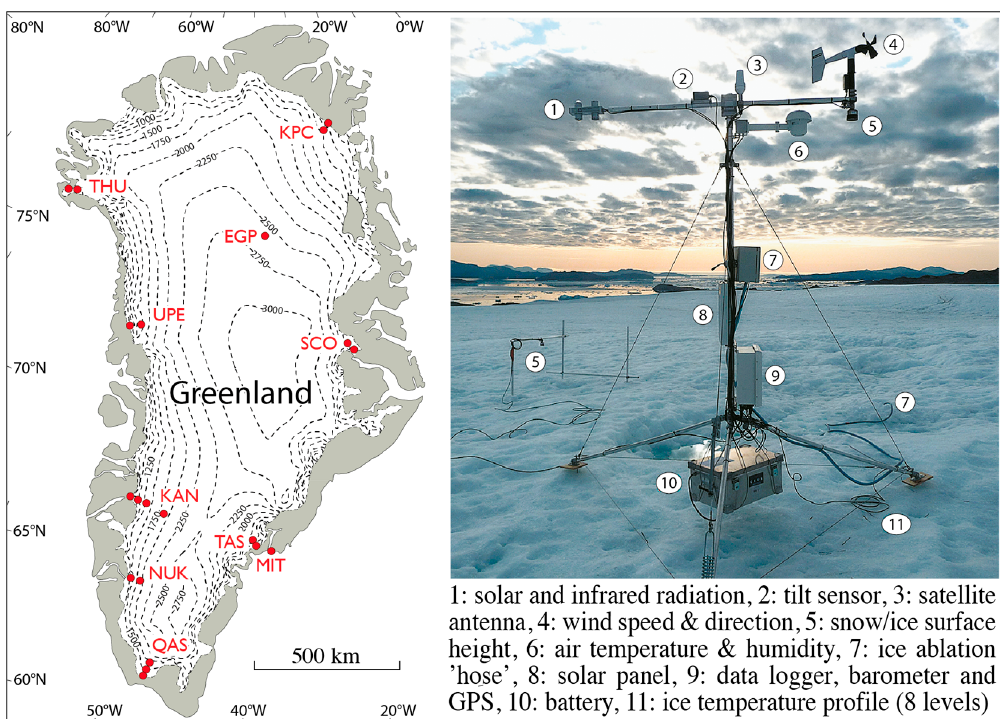
Figure 14. PROMICE_map, ( left ) location of Programme for Monitoring of the Greenland Ice Sheet (PROMICE) automatic weather stations (AWSs). ( Right ) photo of a PROMICE AWS with instrumentation indicated with numbering.